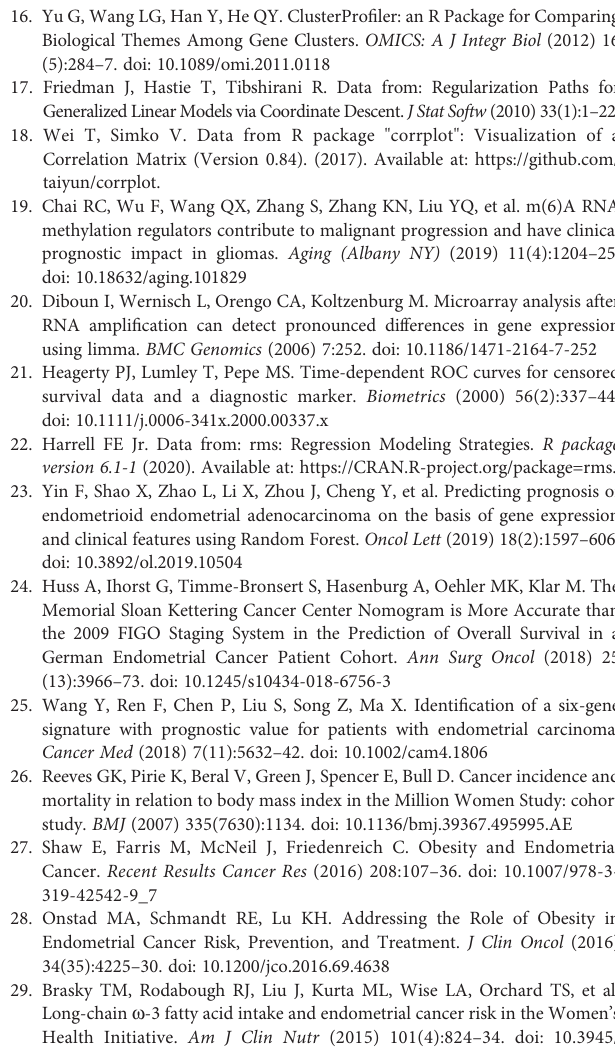
Supplementary Figure 5 | Kaplan – Meier survival curves. Validation of the nomogram based on subgroups with different clinical characteristics. (A) EEA histological type. (B) Other types of histology. (C) FIGO stage I and II. (D) FIGO stage III and IV. (E) Patients without recurrence. (F) Patients with recurrence. EEA, endometrioid endometrial adenocarcinoma; FIGO, International Federation of Gynecology and